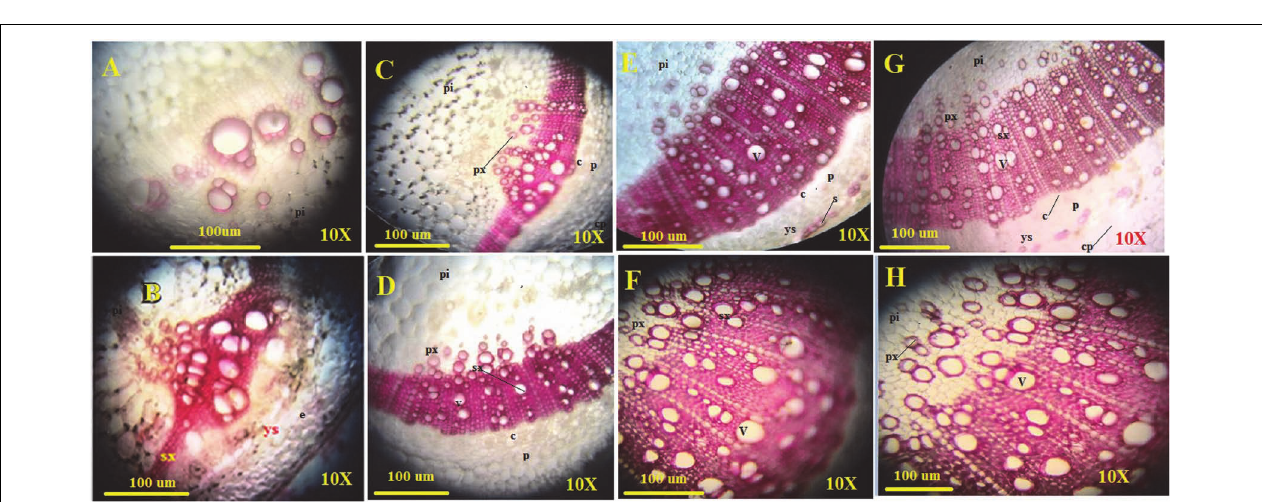
FIGURE 10 | Assessment of the plant defense response in the form of lignification. The figure shows the transverse sections of stem tissues with lignin deposition in the walls of interfascicular fibers and xylem cells collected from four different transverse section of control, Fol challenged, T. erinaceum bioprimed, and T. erinaceum bioprimed + Fol challenged and were collected at two different intervals 15 and 45 days. The stem tissue sections from 2nd internode region were dissected through Vibratome, stained with Phloroglucinol-HCl (pink or fuchsia color). The intensity of the pink color represents higher deposition of lignin. Vascular bundles with lignified primary xylem; sclerenchyma starting to differentiate with no lignified cell walls. (A) Microscopic view of the histochemical section (transverse) of the control stem tissue taken from an unprimed plant (control) at 15 days interval. (B) The control stem tissue analyzed at 45 days interval. (C) The shoot tissue sections from the Fol challenged plant observed at 15 days interval. (D) The Fol challenged shoot tissues at 45 days interval. (E) The shoot tissues were taken from a T. erinaceum bioprimed plant at 15 days interval. (F) T. erinaceum bioprimed tissues at 45 days interval. (G) The shoot tissues taken from Fol challenged sample co-inoculated with T. erinaceum analyzed at 15 days interval. (H) The Fol challenged + T. erinaceum s hoot tissues analyzed after 45 days interval. All the images were observed at 10 × magnification. Bar = 100 µ M. px, primary xylem; sx, secondary xylem; f, xylem; pi, pith; p, phloem; c, cambium; v, vessel; cp, cortical parenchyma. The amount of lignin deposition was maximum in tissues that were Fol challenged and co-inoculated with Trichoderma.